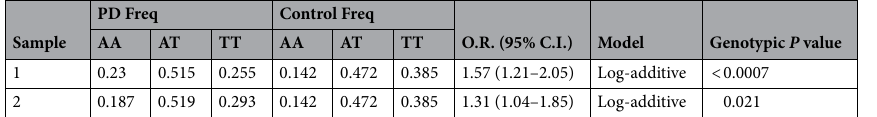
Table 1. Genotypic association between rs710223 and PD in two independent clinical series. Genotypic test calculated in SNPstats software with sex- and age-adjustment of P values. Sample 1 from DNA Bank: PD: 200, Controls: 268; Sample 2 a clinical series of 264 PD patients. The genotypic test was chosen as the genetic test model with a lower AIC/lower P value. Freq. = frequency; O.R. = Odds Ratio.